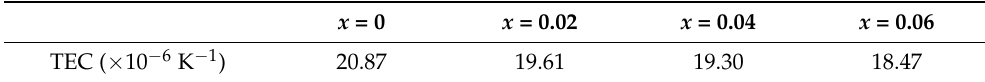
Table 2. TECs of LBCM x .